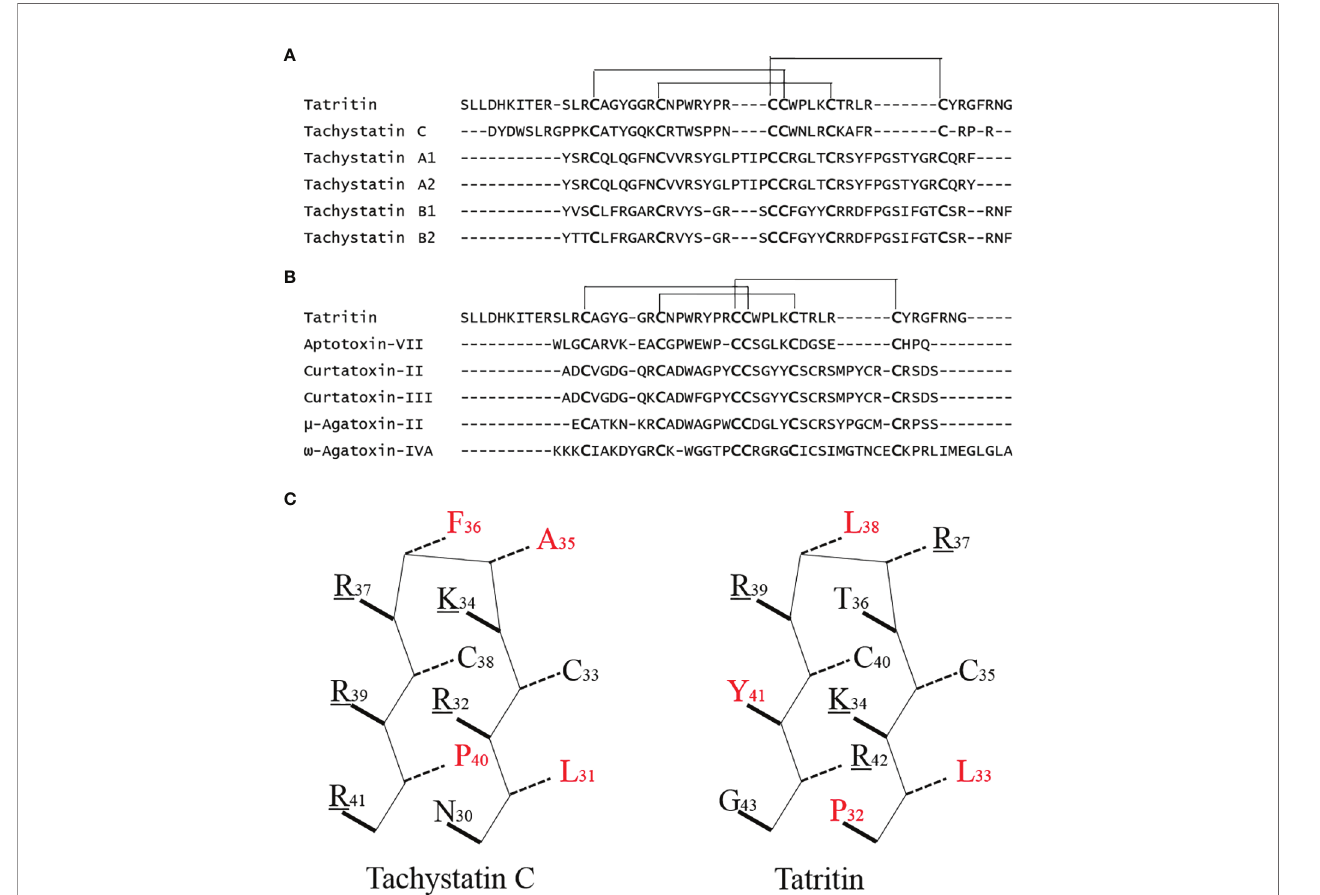
FIGURE 8 | Sequence comparison of Tatritin, Tachystatins, and Neurotoxins from spider venoms. (A) Amino acid sequence alignment of Tatritin and Tachystatins. Conserved cysteines are indicated in large boldface letters. Lines show the identical pattern of disul fi de bonds in Tatritin and Tachystatins. (B) Alignment of the amino acid sequence of Tatritin with those of insecticidal peptides from venom of the spiders. Conserved cysteines are indicated in large boldface letters. Lines show the identical pattern of disul fi de bonds in Tatritin and Neurotoxins. (C) b -Sheet structural models of the C-terminal regions of Tatritin and Tachystatin C. Solid/dashed lines indicate side chains pointing out of/into the plane of the diagram. Basic and hydrophobic amino acid residues are indicated in underline and red highlight, respectively. The numbers indicate the positions of amino acid residues in the mature